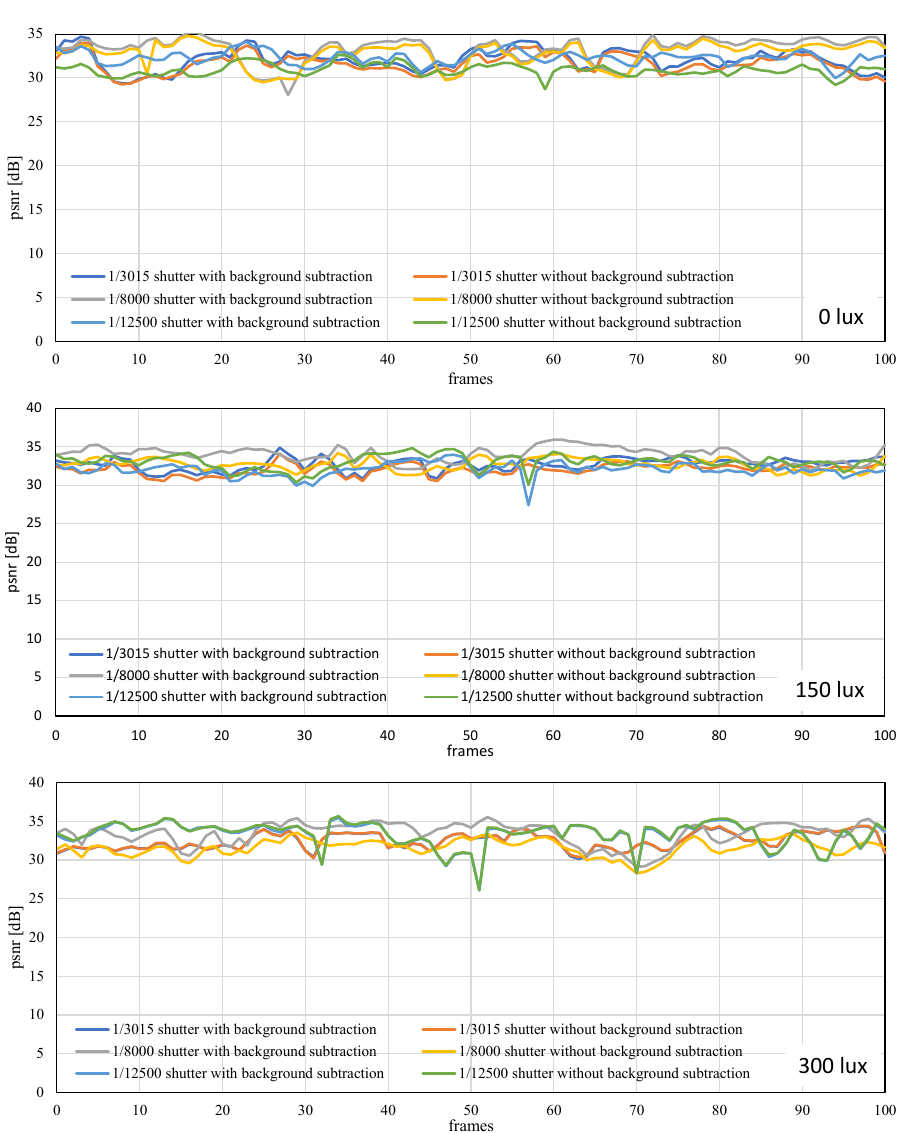
Figure 24. PSNRs when the USB camera video sequence is streamed through HFR projector-1.